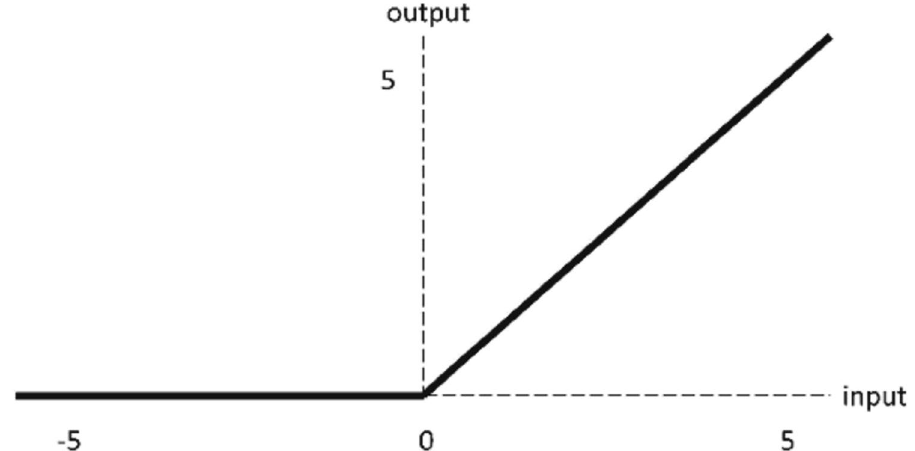
Figure 6. The ReLU activation function.